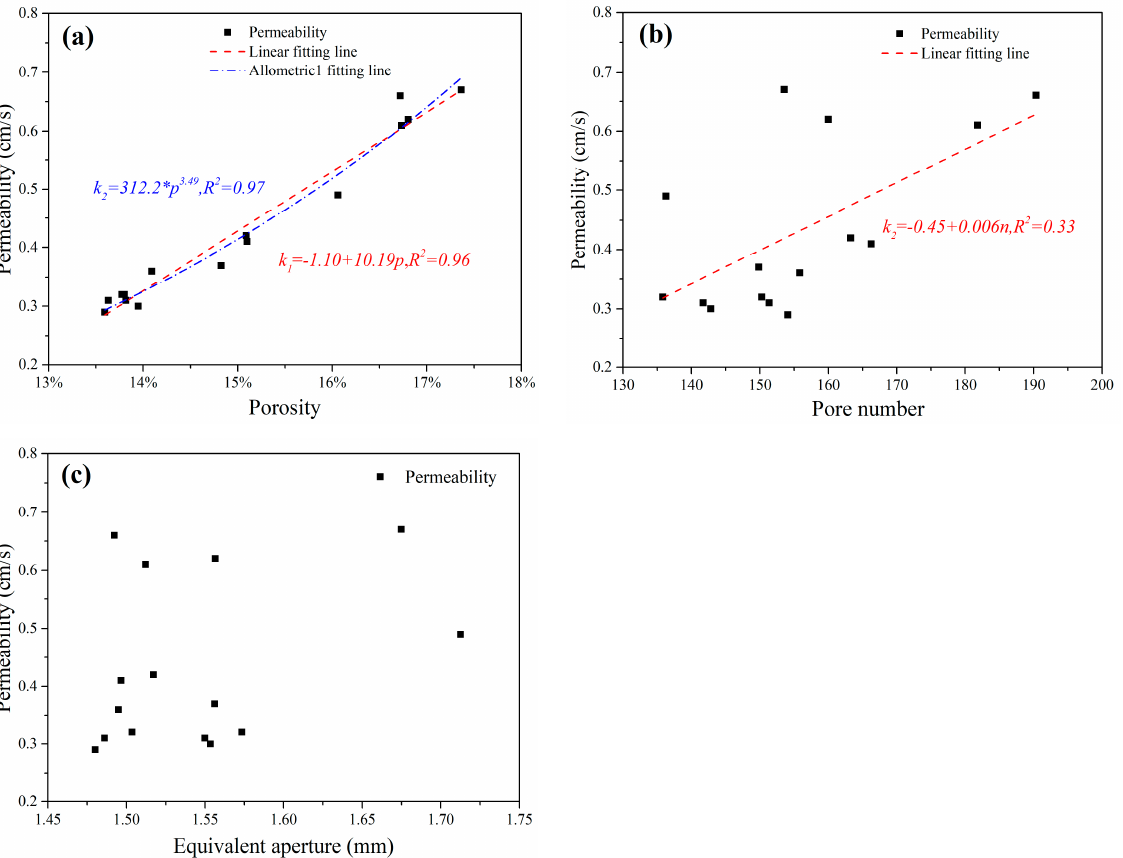
Figure 7. The relationship between permeability and pore characteristics: ( a ) porosity; ( b ) pore number; ( c ) equivalent aperture.